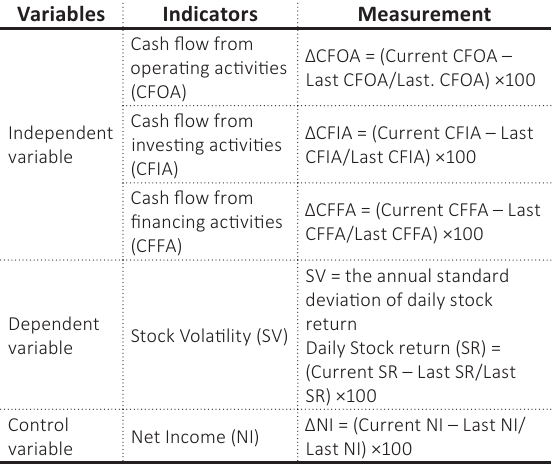
Table 1. Study variables and